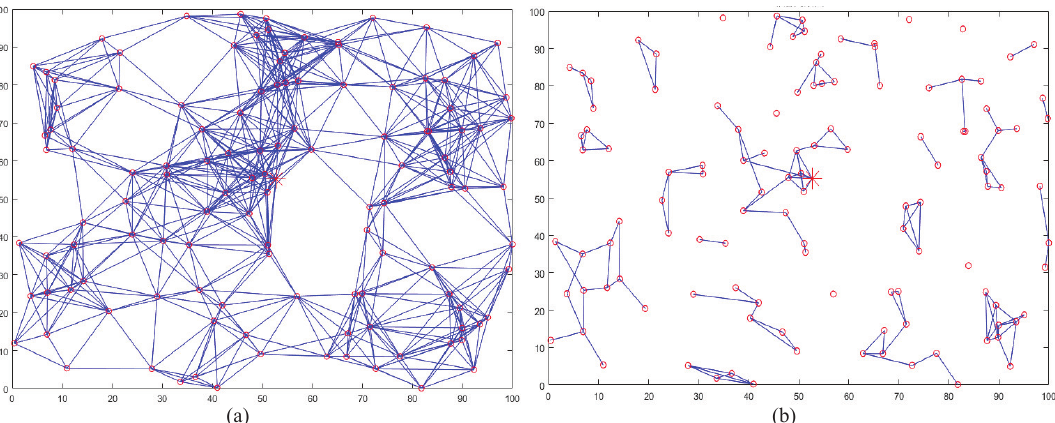
Figure 5. Topologies in simulations; ( a ) the beginning; ( b ) the end.